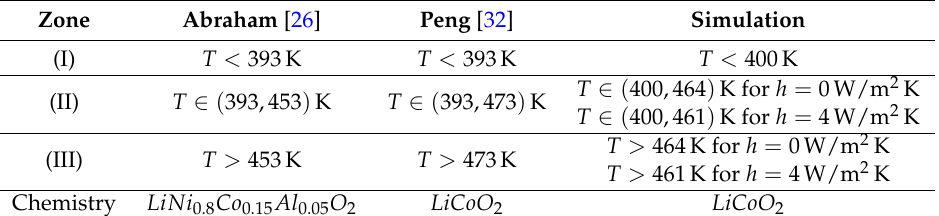
Table 2. Classification of the time evolution of the temperature during thermal